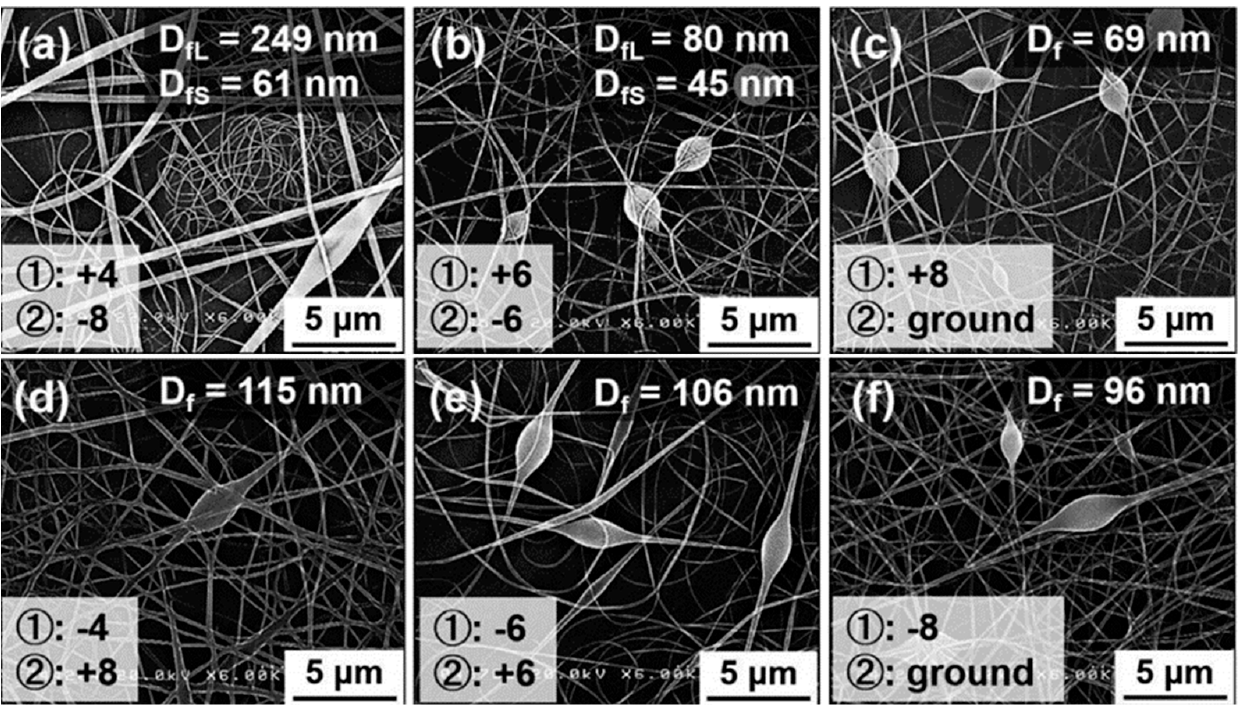
Figure 6. SEM images of the spun precursor containing 8 wt% PVP and 0.2 wt% CNFs with various needle and collector voltages: ( a ) 4 and − 8 kV, ( b ) 6 and − 6 kV, ( c ) 8 kV and ground, ( d ) − 4 and 8 kV, ( e ) − 6 and 6 kV, and ( f ) − 8 kV and ground [110].